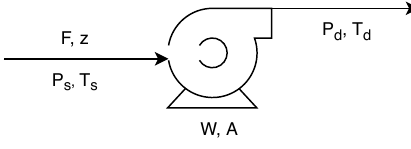
Figure A4. Pump scheme, emphasizing model